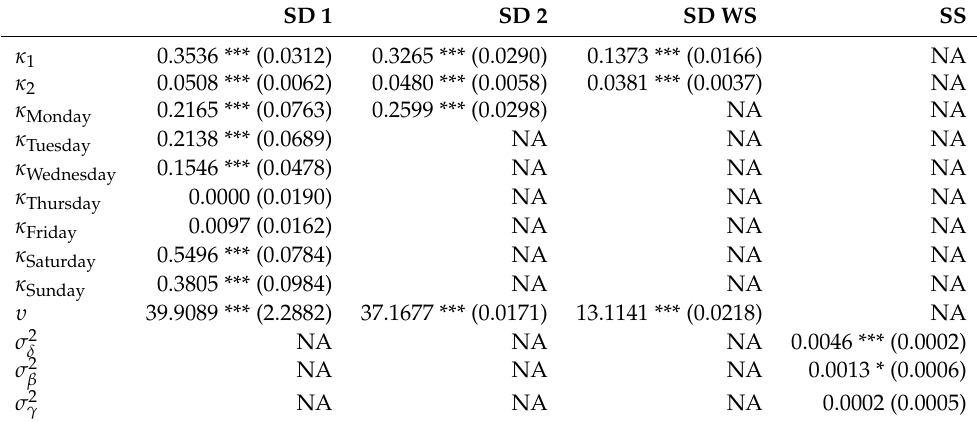
Table A4. Parameter estimates for Chile.